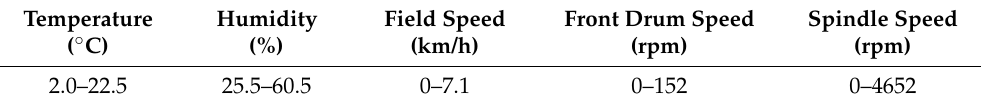
Table 2. Ambient temperature, relative humidity, and working parameters of cotton